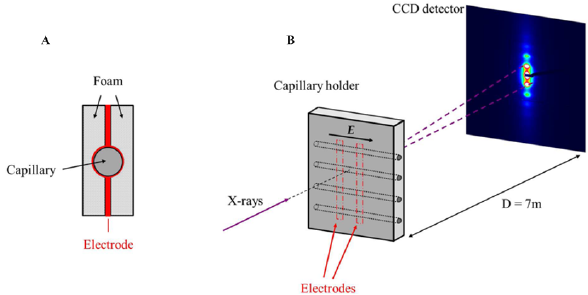
Figure 18: (A) Side view of the capillary holder; (B) Scattering geom- etry of the experiment [102]